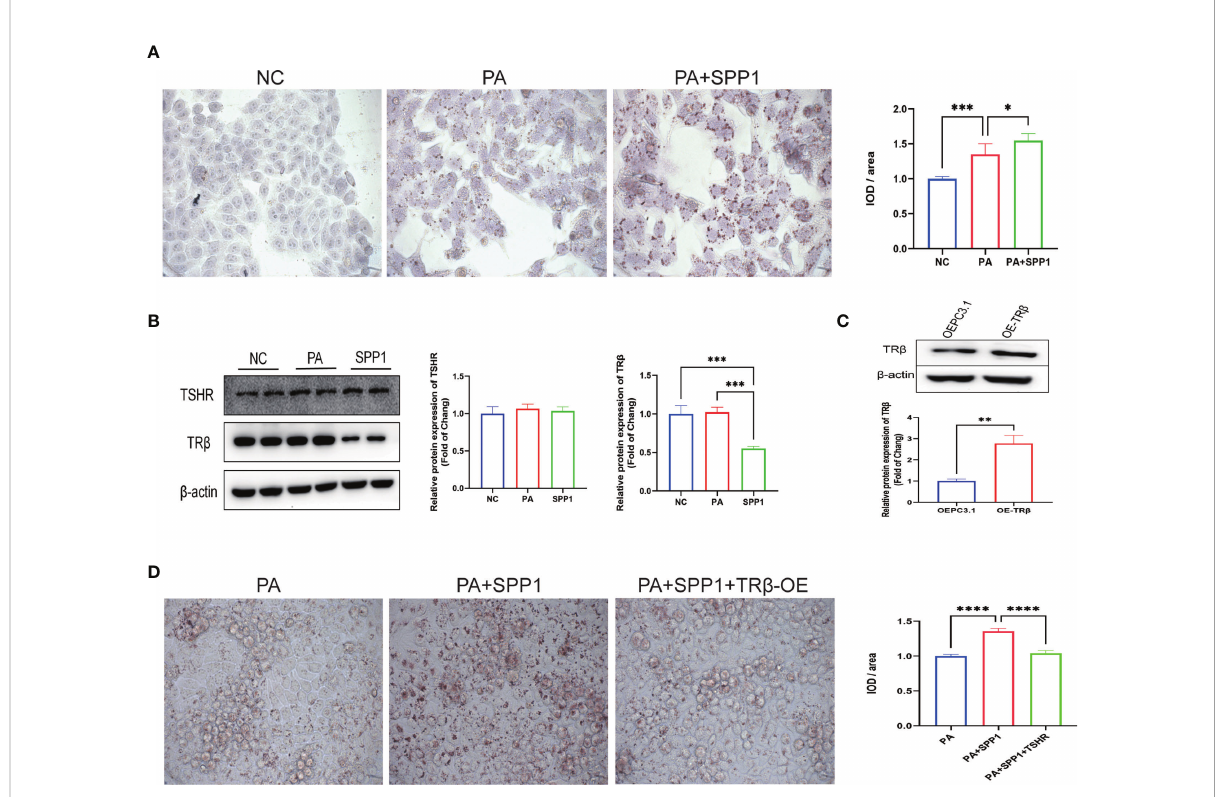
FIGURE 6 Secreted phosphoprotein 1 (SPP1) induced THRB downregulation aggravated lipid accumulation in HepG2 cells. (A) Lipid deposition in each group detected by Oil Red O staining. (B) Quanti fi cation of the average band densities calculated from western blots, the protein levels of TSH receptor (TSHR) and TR b in these groups. (C) THRB was overexpressed in HepG2 cells and this was validated by western bloting. (D) Lipid deposition in those groups detected by Oil Red O staining. Values are the mean ± SD. n = 3 independent experiments. *p < 0.05, **p < 0.01, ***p < 0.001, ****p <